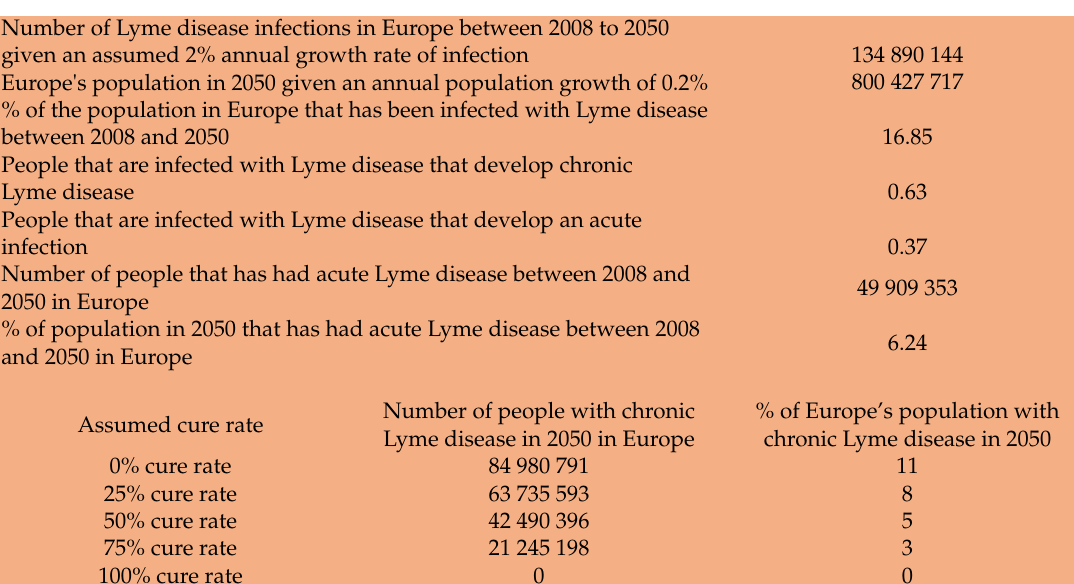
Table 9. Number of people with chronic Lyme disease in 2050 in